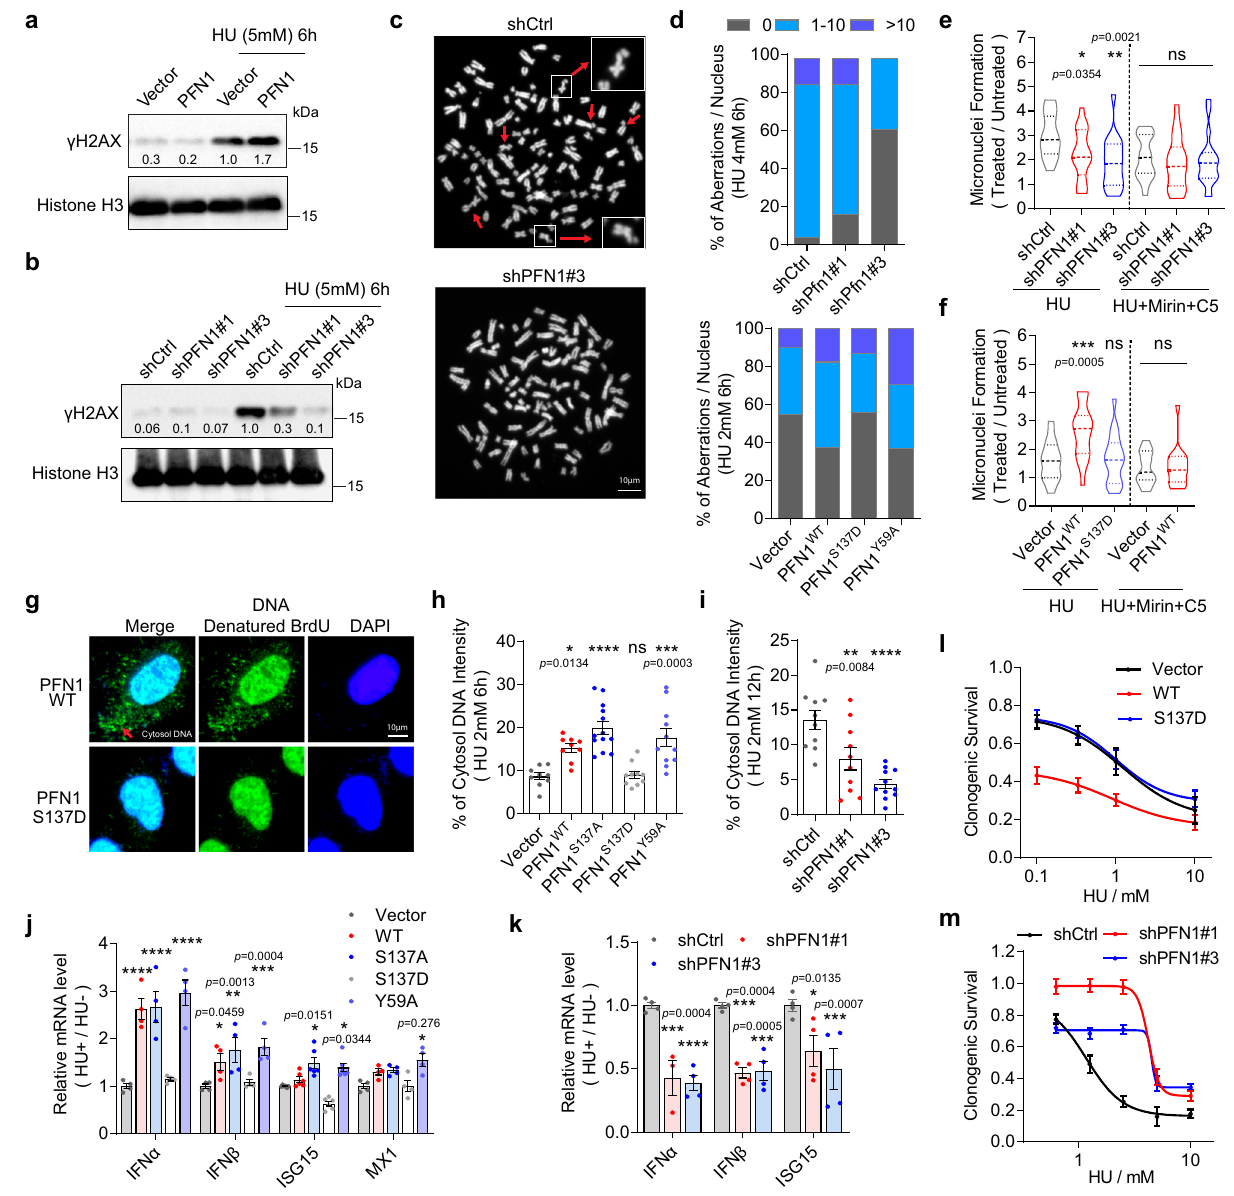
Fig. 5 | PFN1 increases genome instability during replication stress. a , b γ H2AX induction in MCF-10A cells following HU treatment (5mM, 6h). Insoluble fractions afterRIPAlysiswereanalyzedbyWesternblot. γ H2AXwasnormalizedtohistoneH3. c , d Metaphase spreads in HeLa cells after 6h HU (4mM or 2mM) treatment, 20h release,and4hnocodazole(10 μ M)treatment.Aberrantchromosomesareindicated byredarrowsandrepresentativechromosomesaremagni fi edintheinsets.Scalebar, 10 µ m.Around150metaphasesperconditionwereanalyzedfrom n =3independent experiments. e , f Micronuclei in PFN1 knockdown ( e ) or overexpression ( f ) MCF-7 cellsafter6hHU treatment(4mMin e and 2mMin f )withand without50 µ